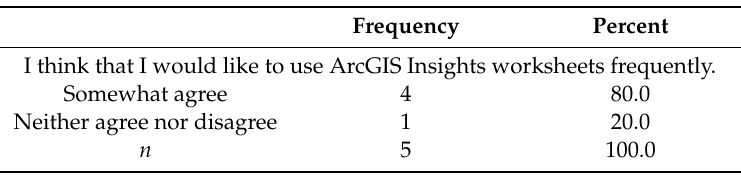
Table 3. Percentages and Frequencies,